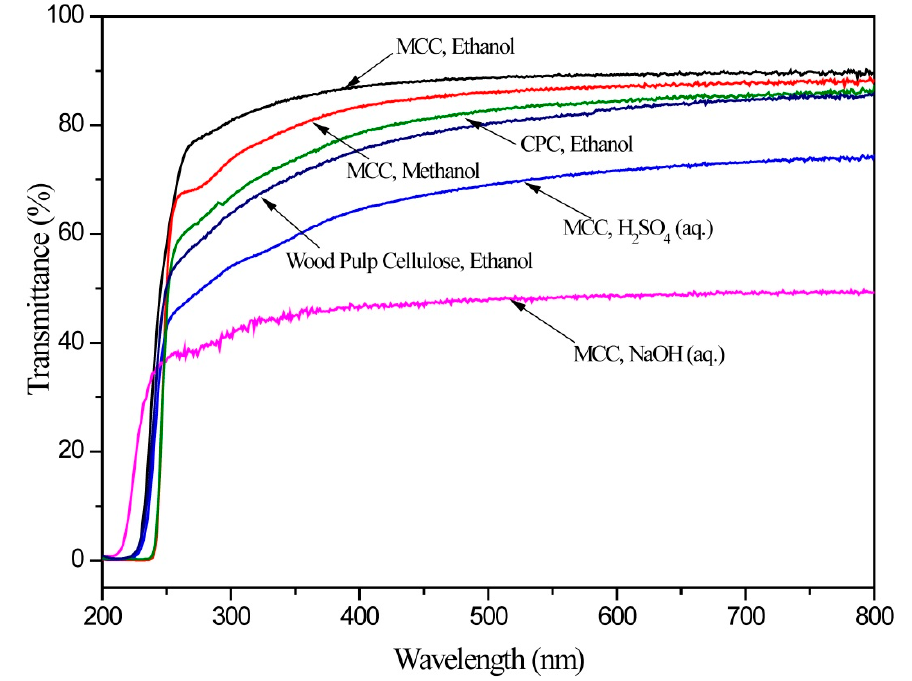
Figure 8. Transmittances of cellulose films.